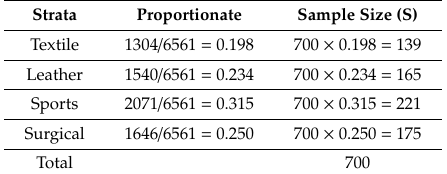
Table 3. The sample size calculation is based on the sampling technique.